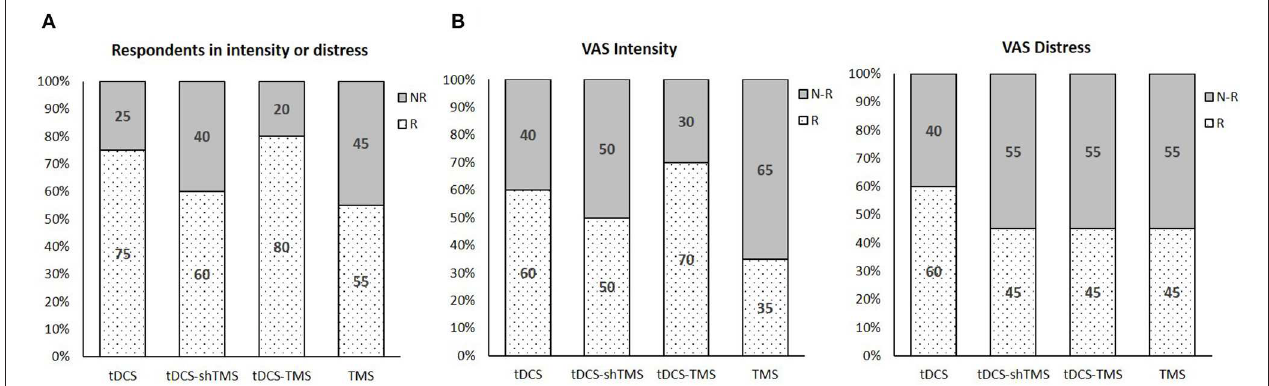
FIGURE 3 | The percentage neuromodulation responders and non-responders with regard to respondents in intensity or distress (A) , VAS intensity (B) , and VAS distress (C) in the 4 study groups. VAS, visual analog scale; Tx, treatment; tDCS, transcranial direct current stimulation; TMS, transcranial magnetic stimulation; sh, sham.